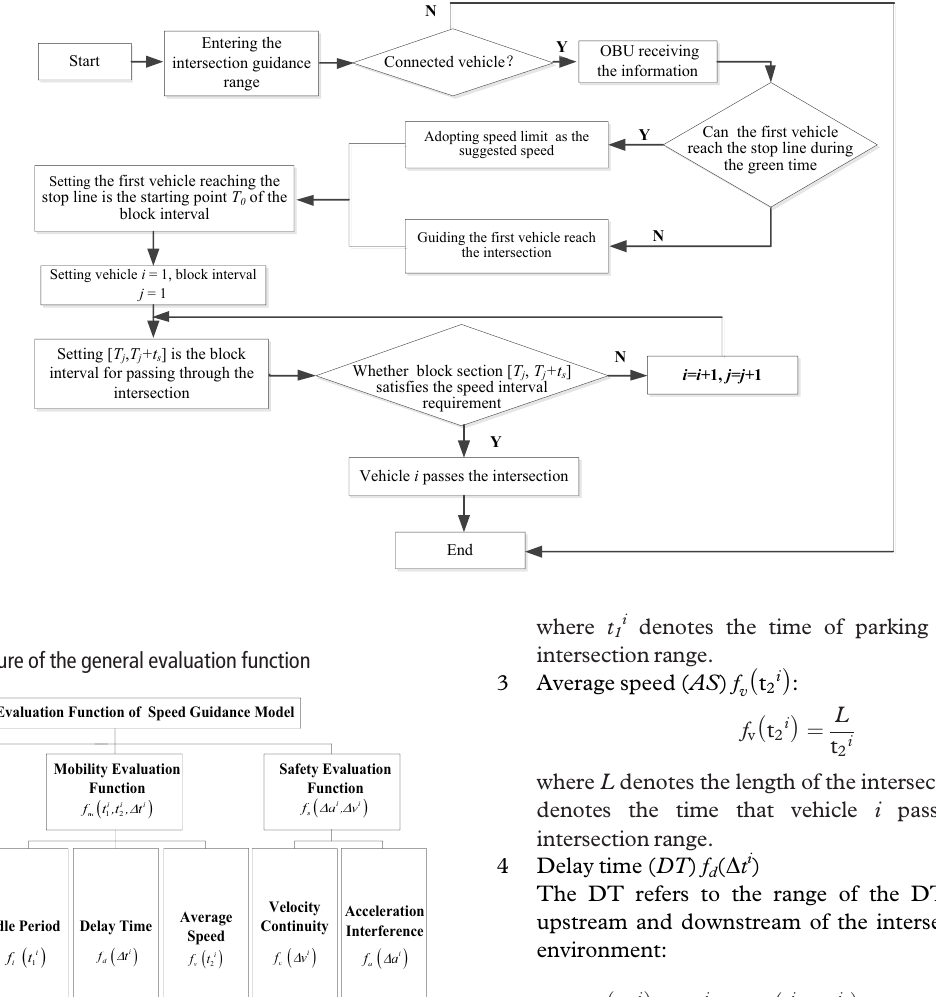
Figure 4 Overall logical fl ow chart of the QMBSG model